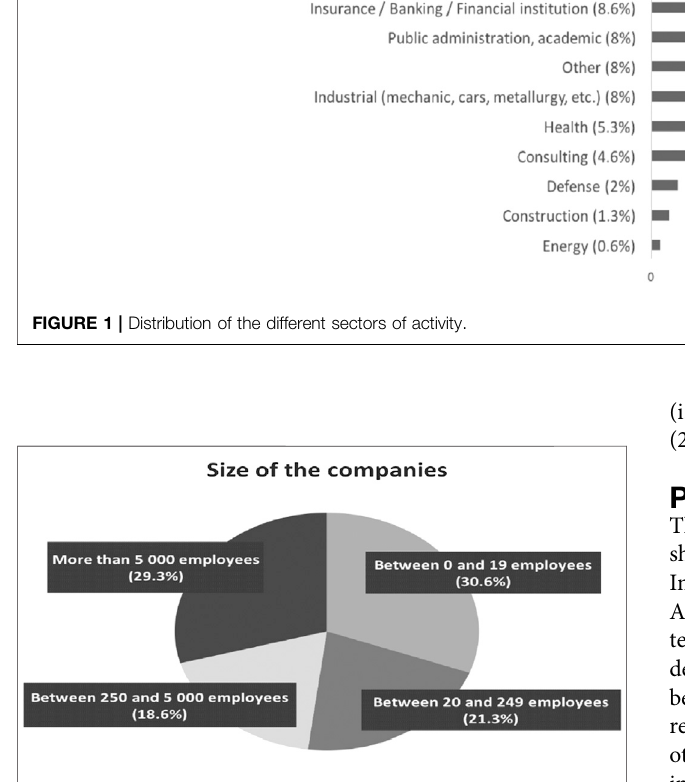
FIGURE 2 | Distribution of the size of the